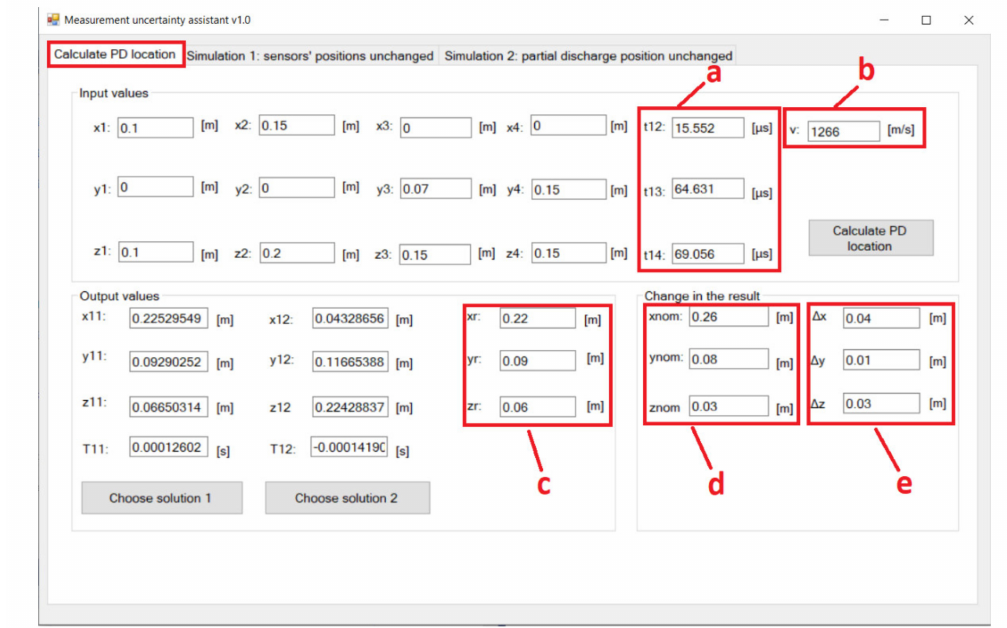
Figure 13. Using MUA software to determine ∆ g max for PD position 8 in Table 3. ( a ) Measured average values of TDOAs while temperature of the transformer oil was 20 ◦ C; ( b ) the incorrect sound velocity value that corresponds to transformer oil temperature of 60 ◦ C; ( c ) calculated PD location using the incorrect value for sound velocity; ( d ) calculated PD location using the correct value for sound velocity (the nominal value of 20 ◦ C); ( e ) change in the result over the axes ( ∆ g max = ∆ x = 0.04